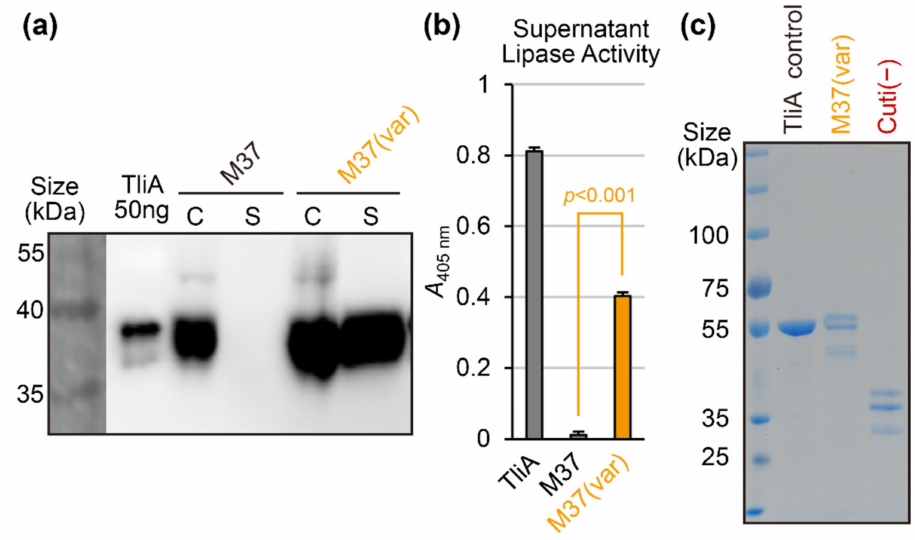
Figure 6. The secretion and supernatant activity of M37(var) lipase and Cuti( − ). ( a ) A mutant clone of M37 obtained from random mutation and activity-screening strategy, M37(var), was tested for secretion. ( b ) The activity of the culture supernatant was measured for lipase/cutinase activity of three different enzymes in the supernatant. The activity of TliA and M37 lipase was measured using pNPP and the activity of cutinase using pNPB. ( c ) SDS-PAGE of culture supernatants. 16 µ L of culture supernatant was loaded on SDS-PAGE and stained with Coomassie blue. The culture supernatant consisted only of the respective target proteins: M37(var) and Cuti( − ). Note that each of these proteins were separated into several bands corresponding to oxidized and reduced forms of LARD3-conjugated proteins (upper two bands) and lower LARD3-cleaved